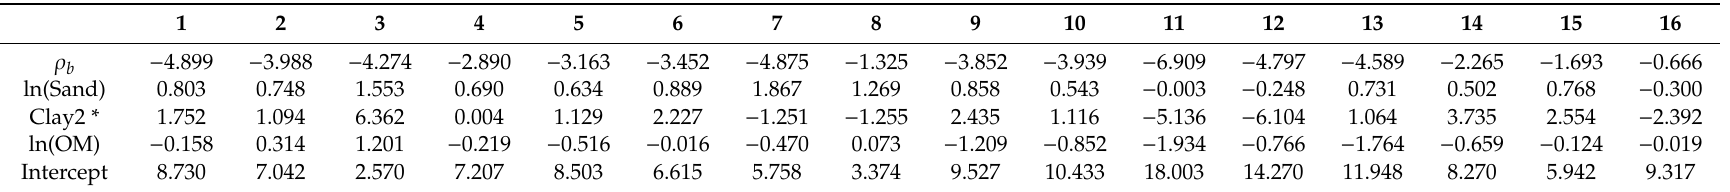
Table 8. Regression coe ffi cients of categorical PTFs for the logarithmized saturated hydraulic conductivity with only soil